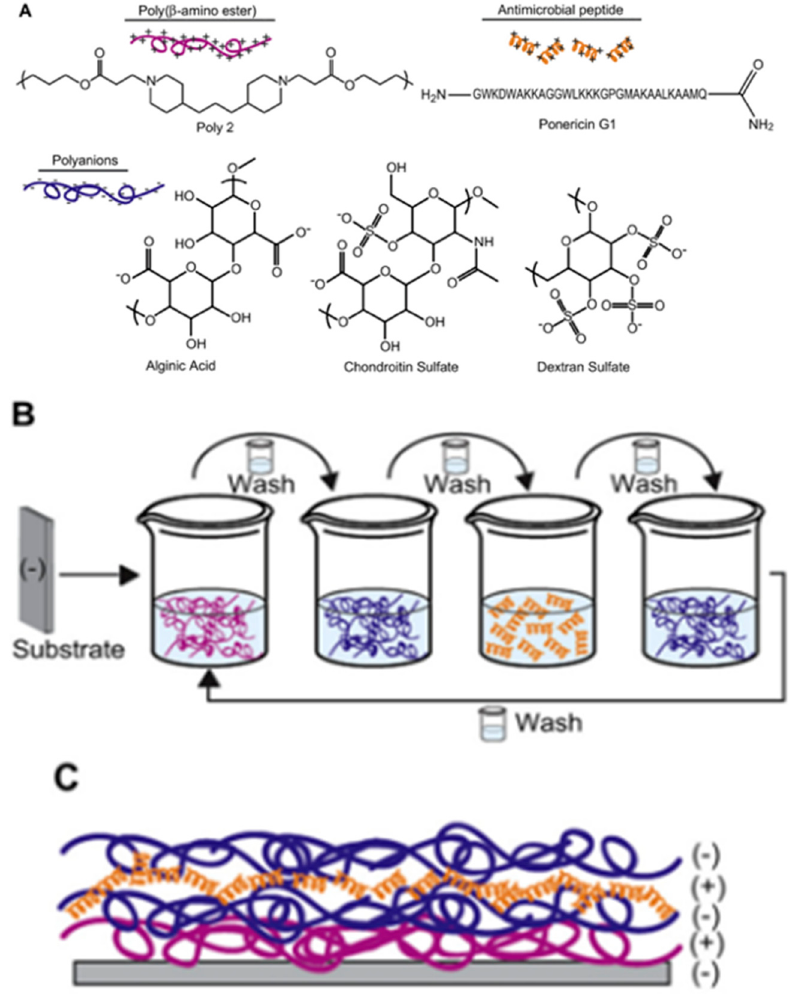
Figure 24. Process used for the immobilization of ponericin G1 embedded with the LbL structure ( A ) structures of all polyelectrolytes used in the LbL process. ( B ) schematic protocol of LbL elaboration and ( C ) Schematic expected structure of the final LbL film. Reproduced from [88]. Copyright © 2009 Elsevier Ltd. All rights reserved.